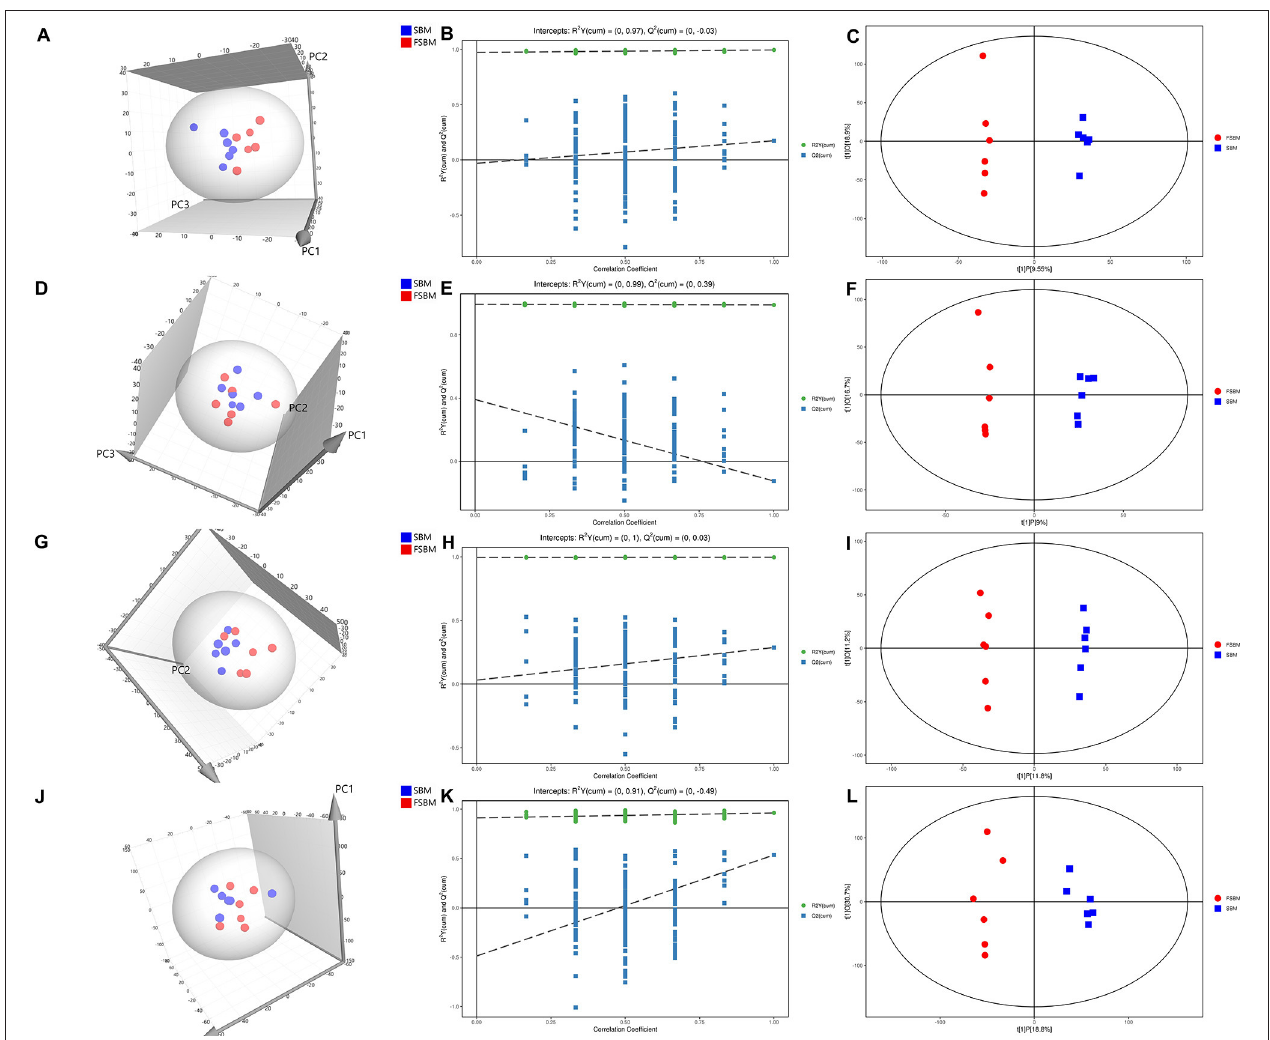
FIGURE 3 | 3D score scatter plots of principal component analysis (PCA) (A,D,G,J) , permutation test plots of orthogonal projections to latent structures-discriminant analysis (OPLS-DA) (B,E,H,K) , and OPLS-DA score scatter plots (C,F,I,L) for the metabolite profiles in rumen liquid (A–C) , plasma (D–F) , milk (G–I) , and urine (J–L) between two dietary treatments. SBM, soybean meal treatment; FSBM, fermented soybean meal